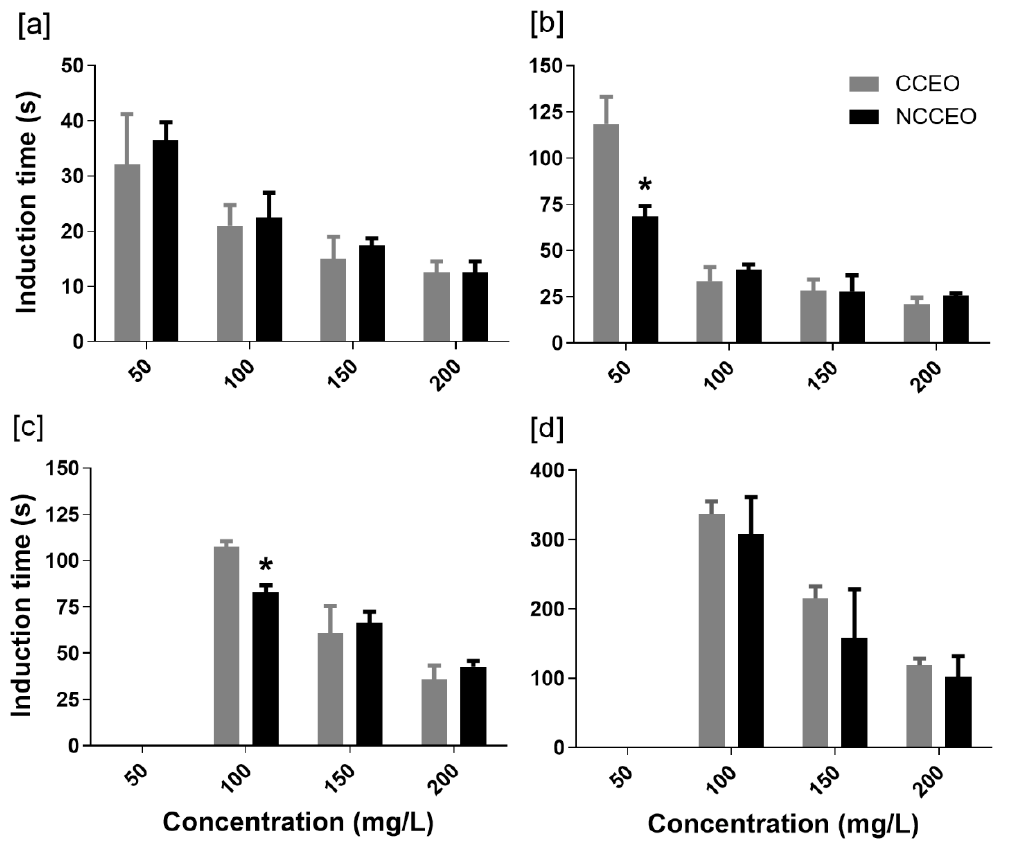
Figure 1. Anesthetic induction time with Chinese cinnamon ( Cinnamomum cassia ) essential oil (CCEO) and its nanoemulsion (NCCEO) in silver catfish ( Rhamdia quelen ) by immersion bath. ( a ) Stage 2; ( b ) stage 3a; ( c ) stage 3b; and ( d ) stage 4. Values are expressed as median ± interquartile range ( n = 8). * Asterisk indicates significant difference from CCEO at the same concentration (Mann–Whitney test, p < 0.05).